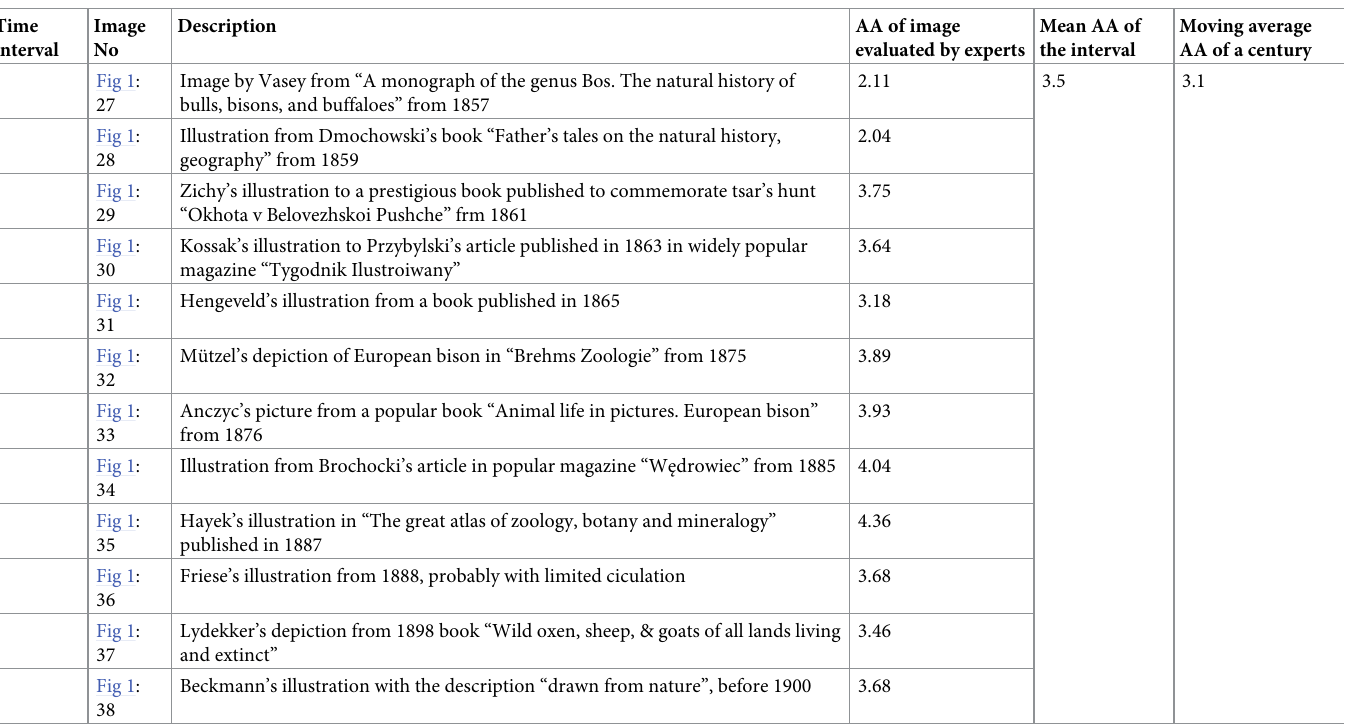
Mean AA of evaluated by experts the interval 2.11 2.04 3.75 3.64 3.93 4.36 3.46